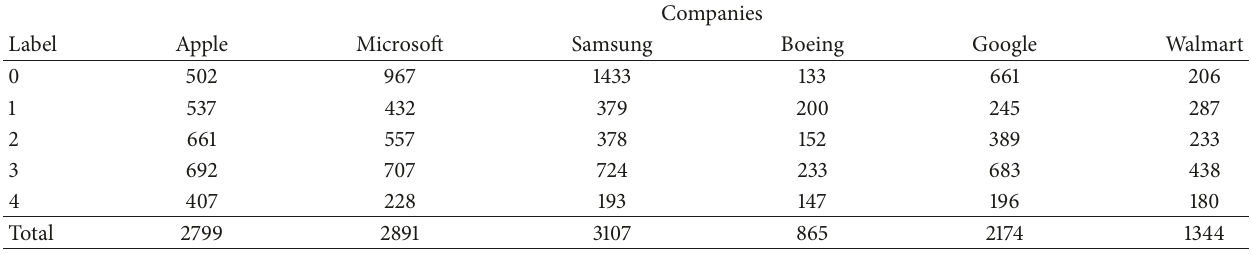
Table 5: Number of event characteristic labels for each company.